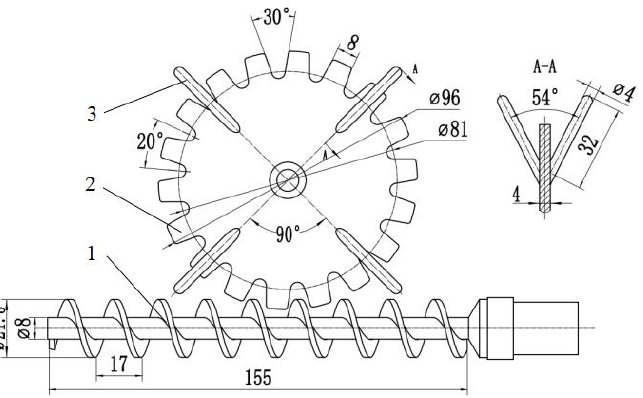
Figure 2. Seed stirring mechanism of seed feeder: 1. Auger. 2. Seed stirring wheel. 3. Seed stirring rod.